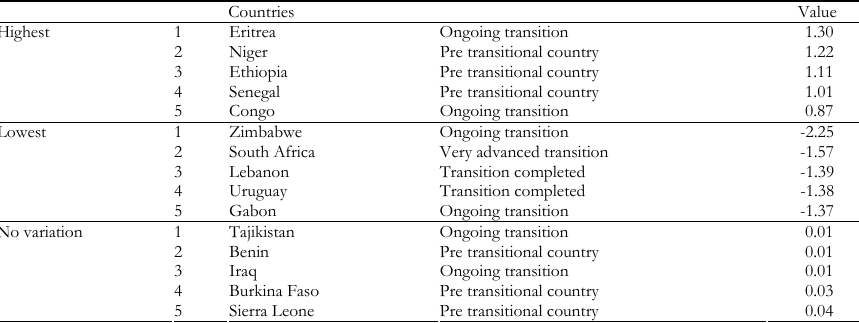
Extreme scores for variation on factor 3 – Population Structure 2010-1996 Countries Value 1 Eritrea Ongoing